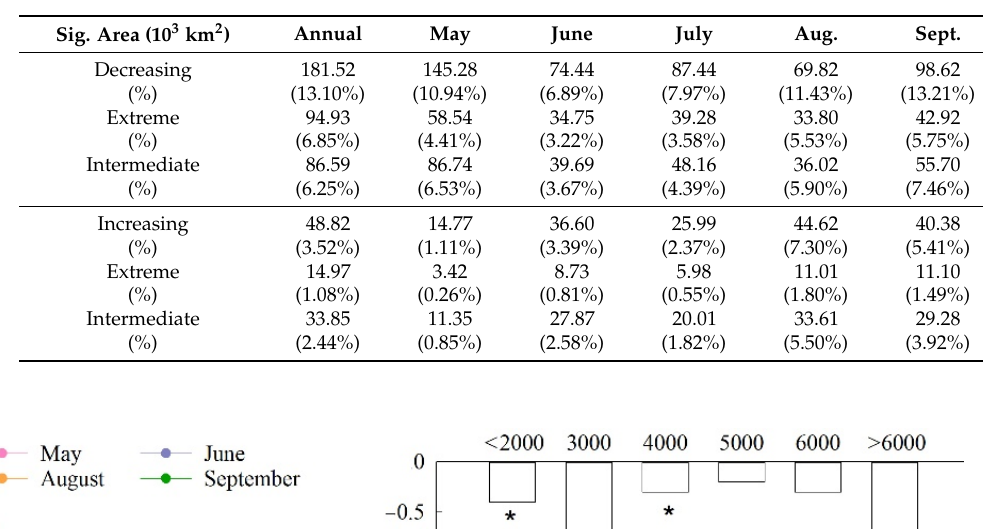
Table 1. The significant change areas in annual and monthly albedo during 2000–2016 on the QTP, The changes include four categories: extreme decrease (slope < 0, p < 0.01), intermediate decrease (slope < 0, 0.01 < p < 0.05), intermediate increase (slope > 0, 0.01 < p < 0.05), and extreme decrease (slope > 0, p < 0.01).